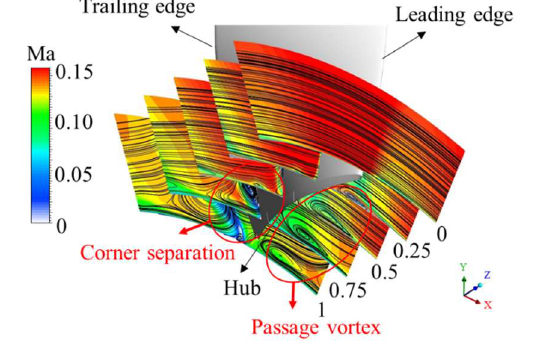
Figure 17. Comparison of streamline distribution and Mach contour near the endwall: ( a ) flow characteristic near the endwall; ( b ) ORI; ( c ) MES; ( d ) MOS; ( e ) MPS.